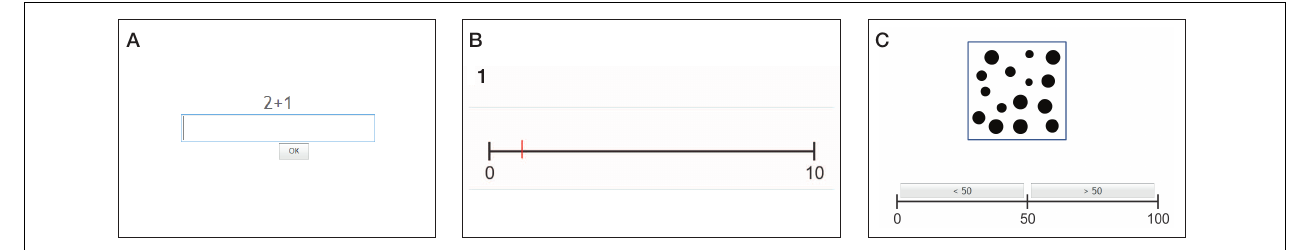
FIGURE 6 | (A) Addition task. (B) Number line task between 0 and 10. (C) Estimation task.